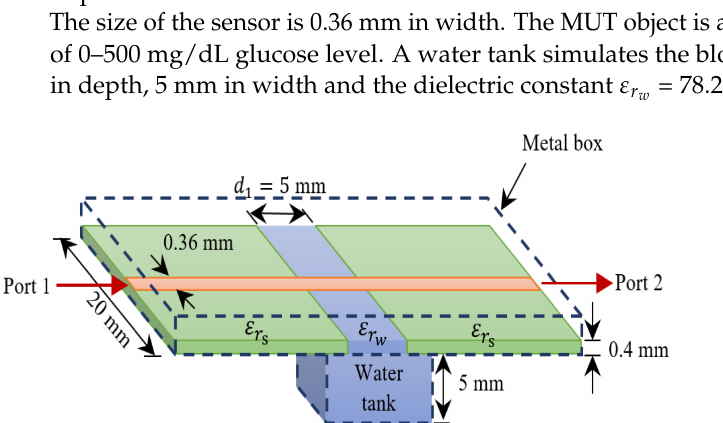
Figure 10. View of the proposed sensor approach (Reprinted with permission from Ref. [98] © 2020